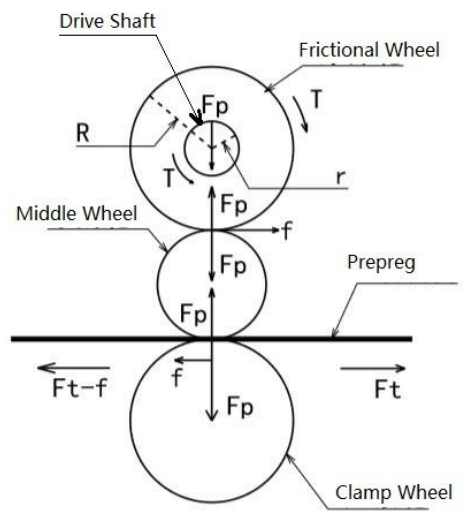
Figure 21. Free body diagram of the real-time tension adjustment Figure 21. F ree body diagram of the real-time tension adjustment device.